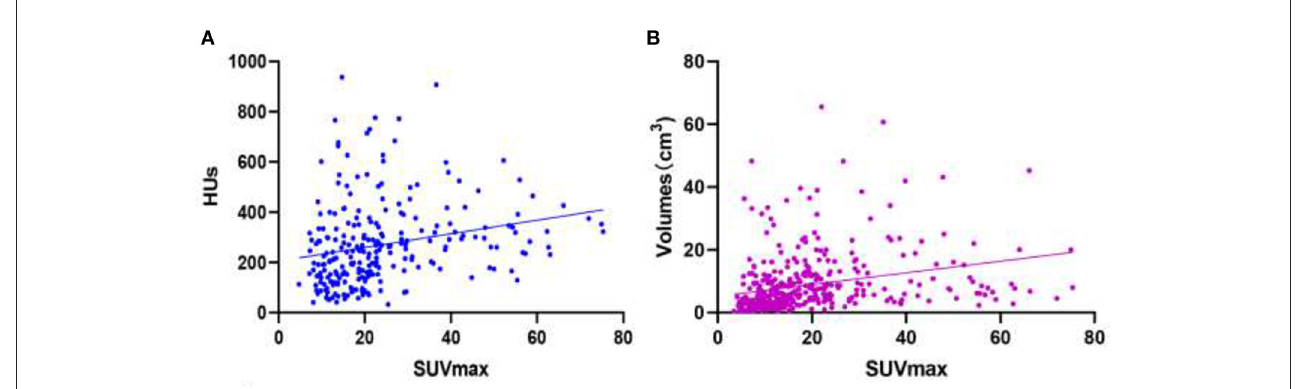
FIGURE7 Images of linear correlation scatter plots. (A) Correlation between SUVmax and HUs from SPECT data for all bone metastatic lesions [ r value = 0.2326 (95% CI 0.1123–0.3463), P -value = 0.0002]. (B) Correlation between SUVmax and volumes (cm 3 ) from SPECT data for all bone lesions [ r value = 0.2772 (95% CI 0.1832–0.3662), P -value < 0.0001].